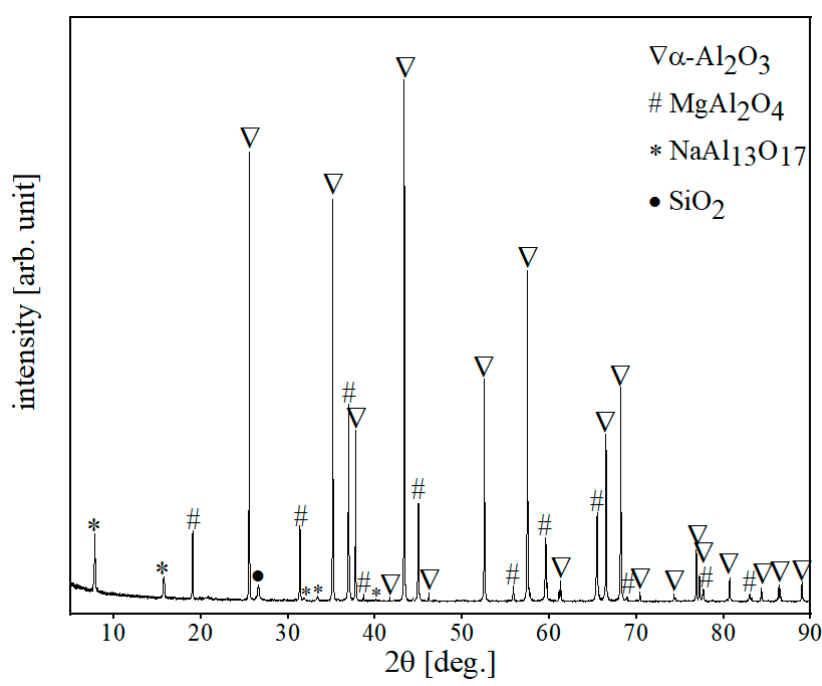
Figure 7. XRD pattern of alumina-spinel refractory.